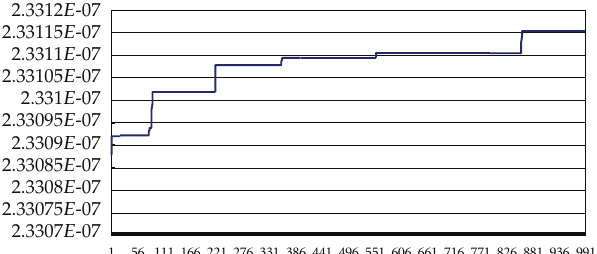
Figure 4: Optimization process diagram based on GA-SA and multiagent.